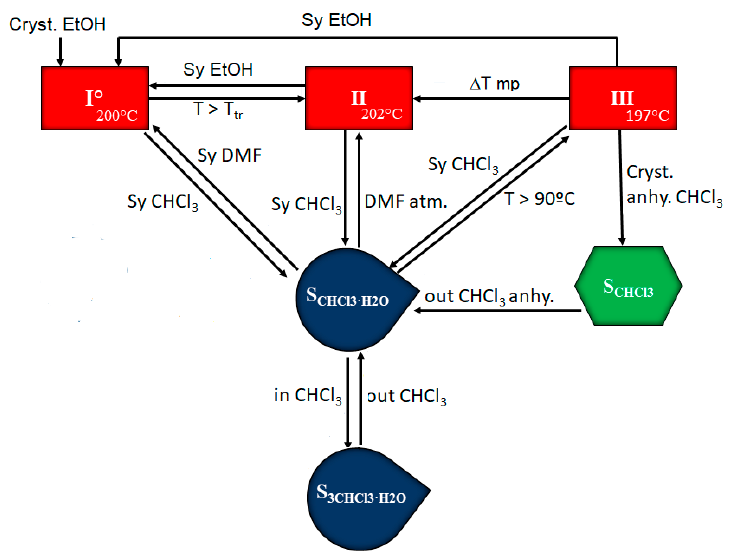
Figure 8. Pathways for phase transformations of BL solid forms as a result of heating or exposure to different solvents.